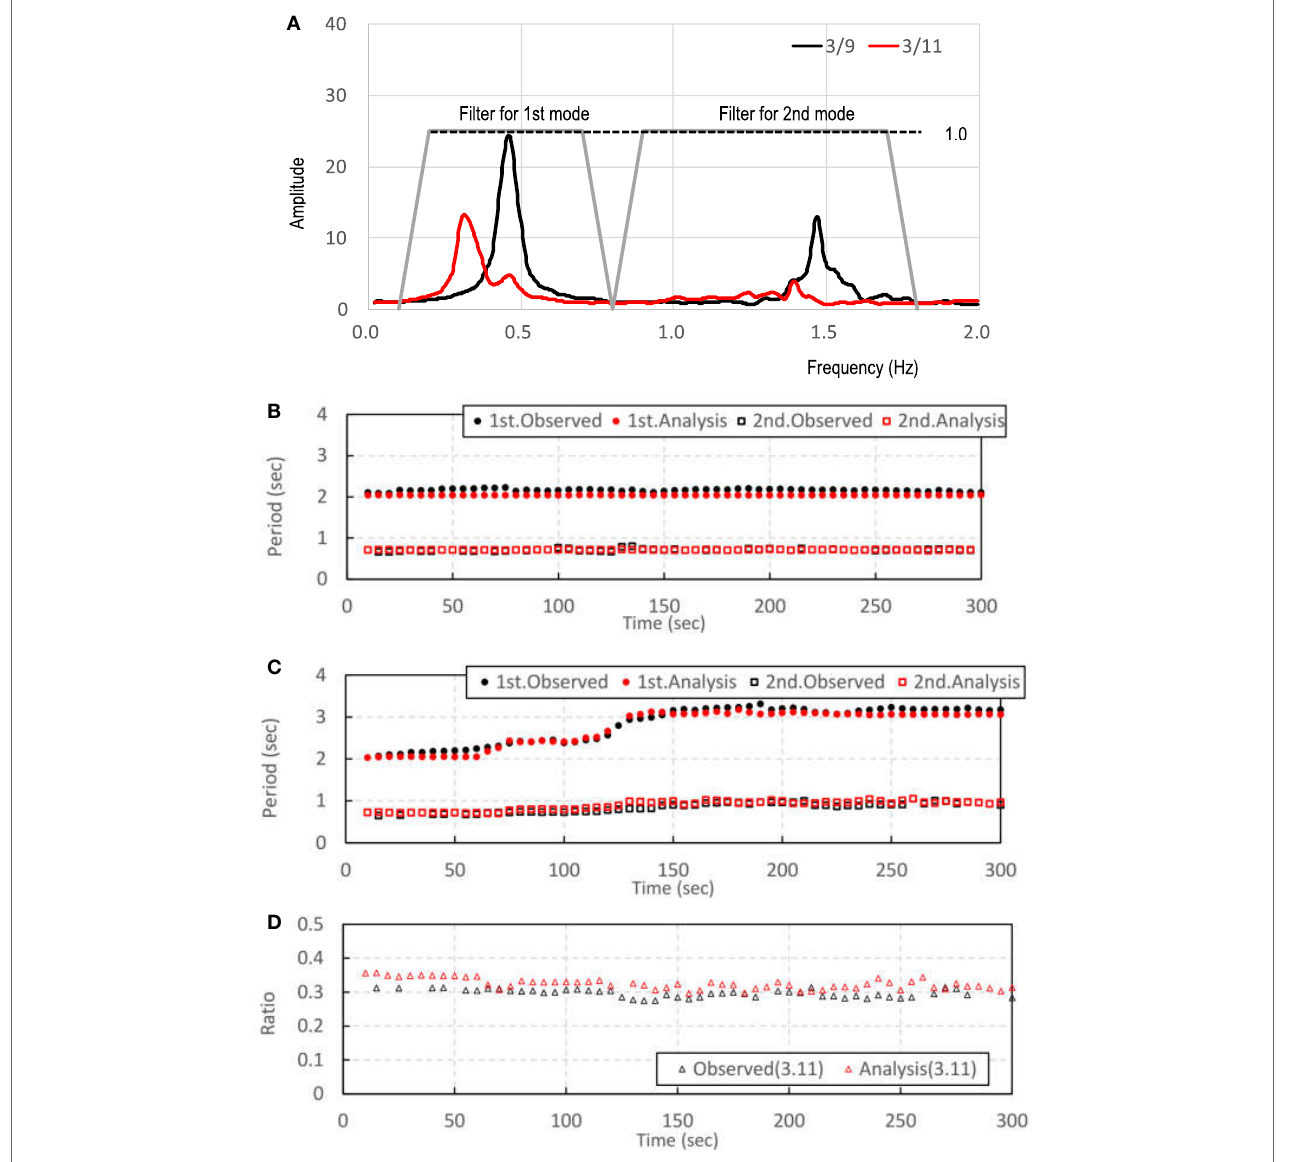
FigUre 13 | Auto-regressive exogenous analysis results for natural period in the N–S direction: (a) transfer functions of the 3/9 pre-shock and 3/11 main shock, and the trapezoidal filter used for both first and second modes, (B) change in first and second natural periods during the 3/9 pre-shock compared for observed and analytical results, (c) those during the 3/11 main shock, and (D) values of the second natural period divided by first natural period for both observed and analytical results during the 3/11 main